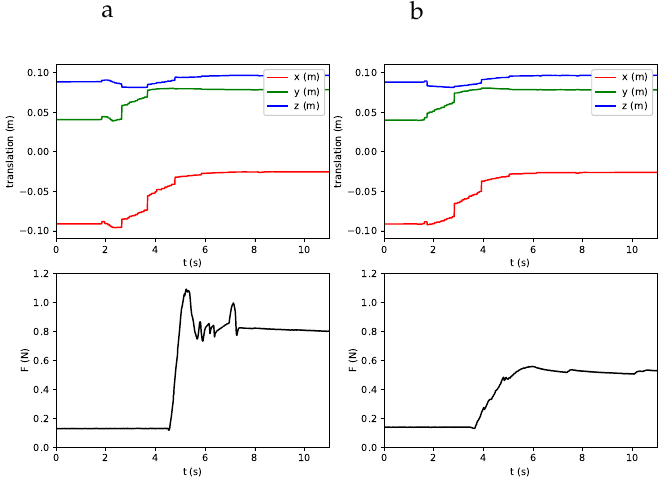
Figure 19. Trajectory of the thumb tip and corresponding tactile force trajectory during pinching the blue pipe from Figure 18a ( a ) and green foam from Figure 18d ( b